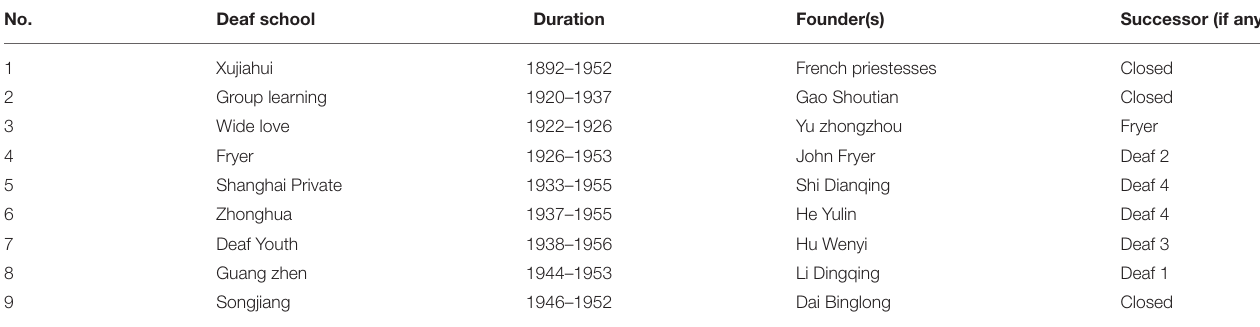
TABLE 2 | A list of deaf schools before